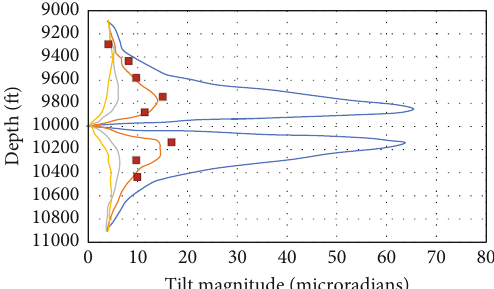
Figure 6: E ff ect of fracture length on the tilt magnitude modi fi ed after